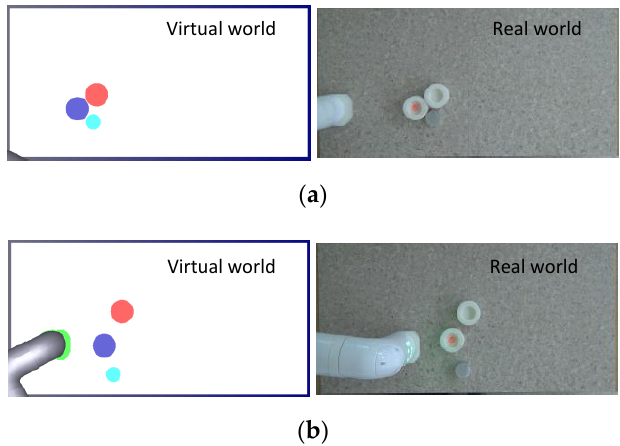
Figure 12. Scattering experiments for singulation of two objects: ( a ) before collision; ( b ) after collision. Manipulator velocity: 0.4 m/s.